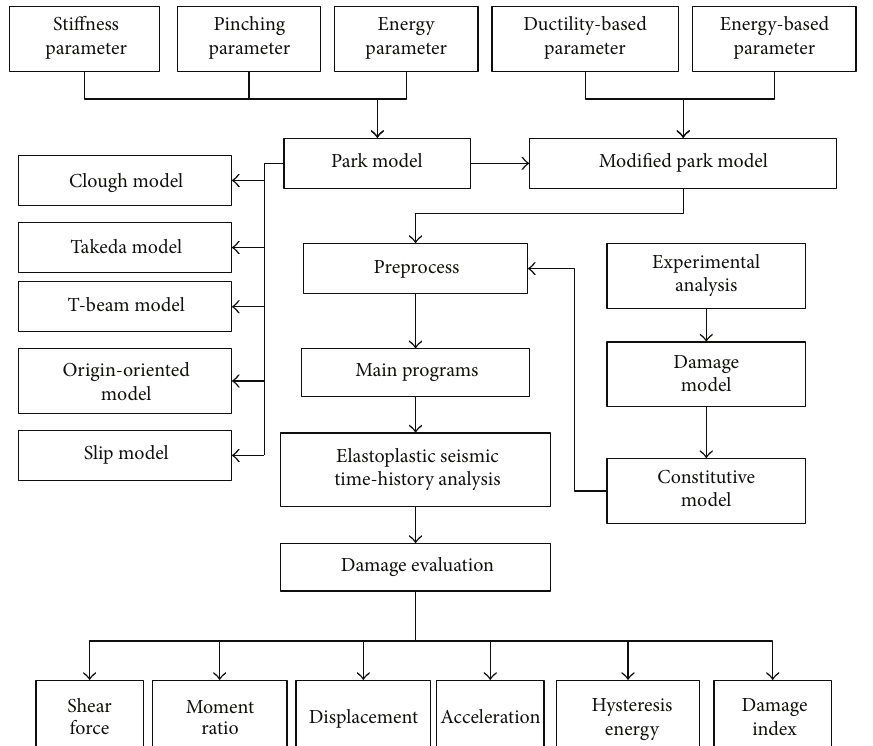
Scheme 1: Programming